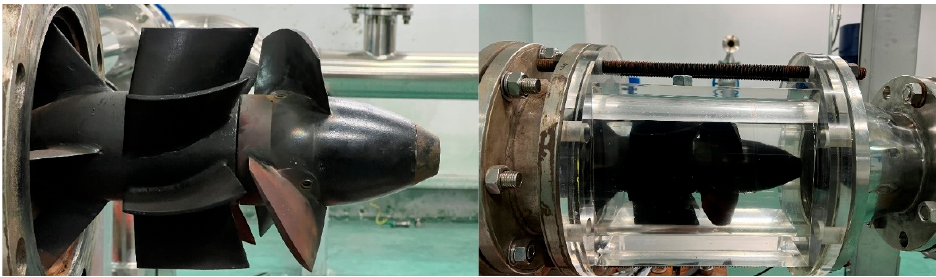
Figure 6. Impeller and guide vane.